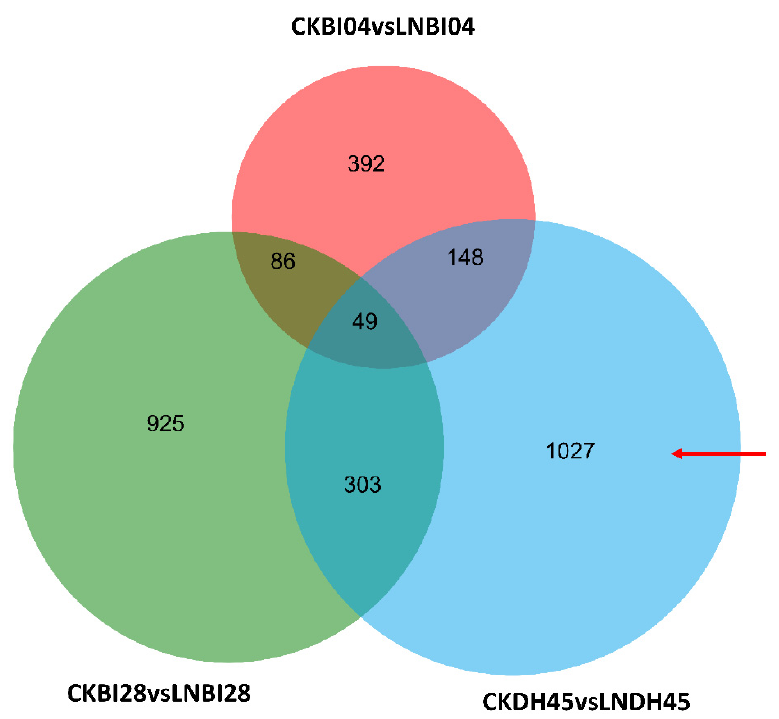
Figure 5. Venn diagrams of DEGs between line DH45 and its parents. The red arrow represents the DEGs specific to DH45; CK vs. LN represents the unique DEGs under the LN condition relative to the CK condition.